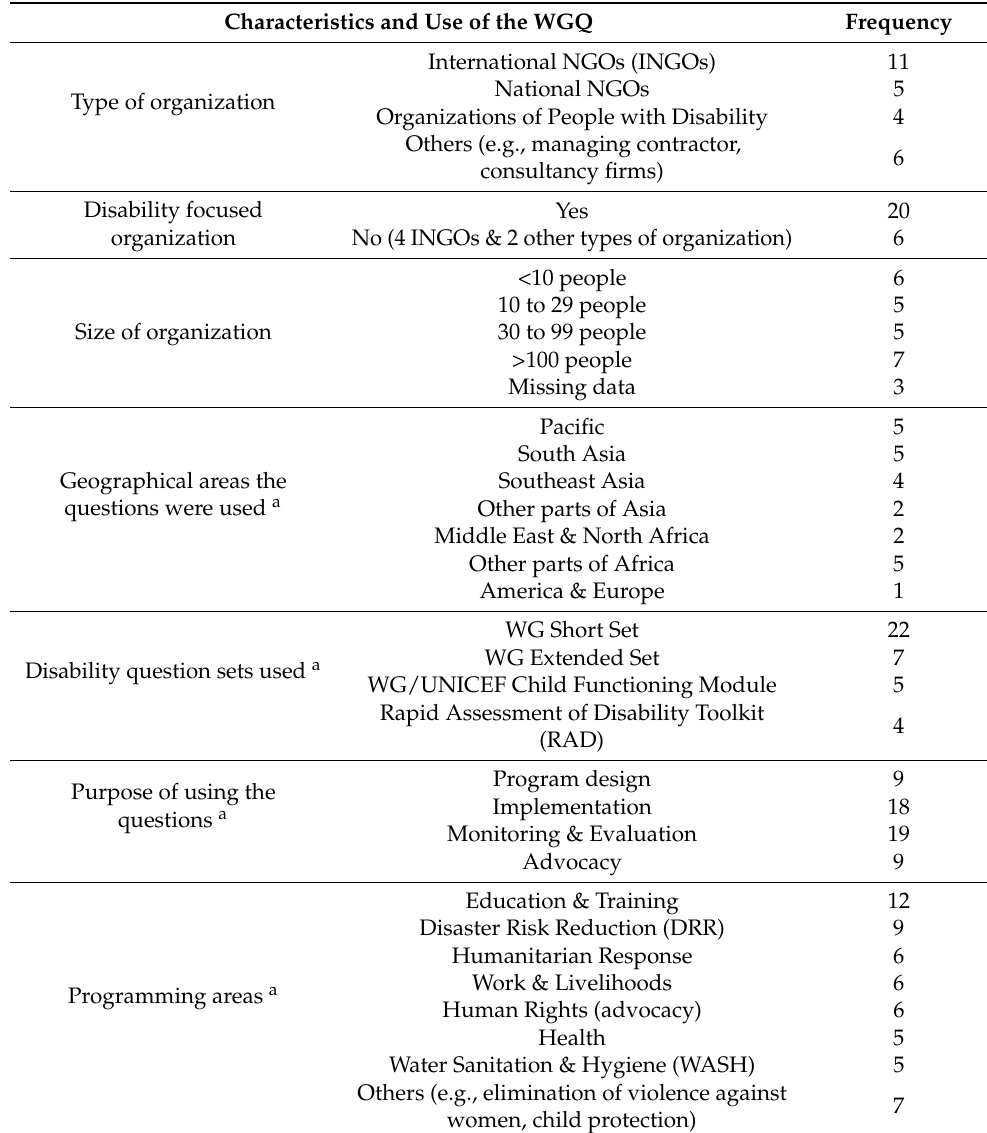
Table 2. Organizational characteristics and use of the WGQ. Characteristics and Use of the